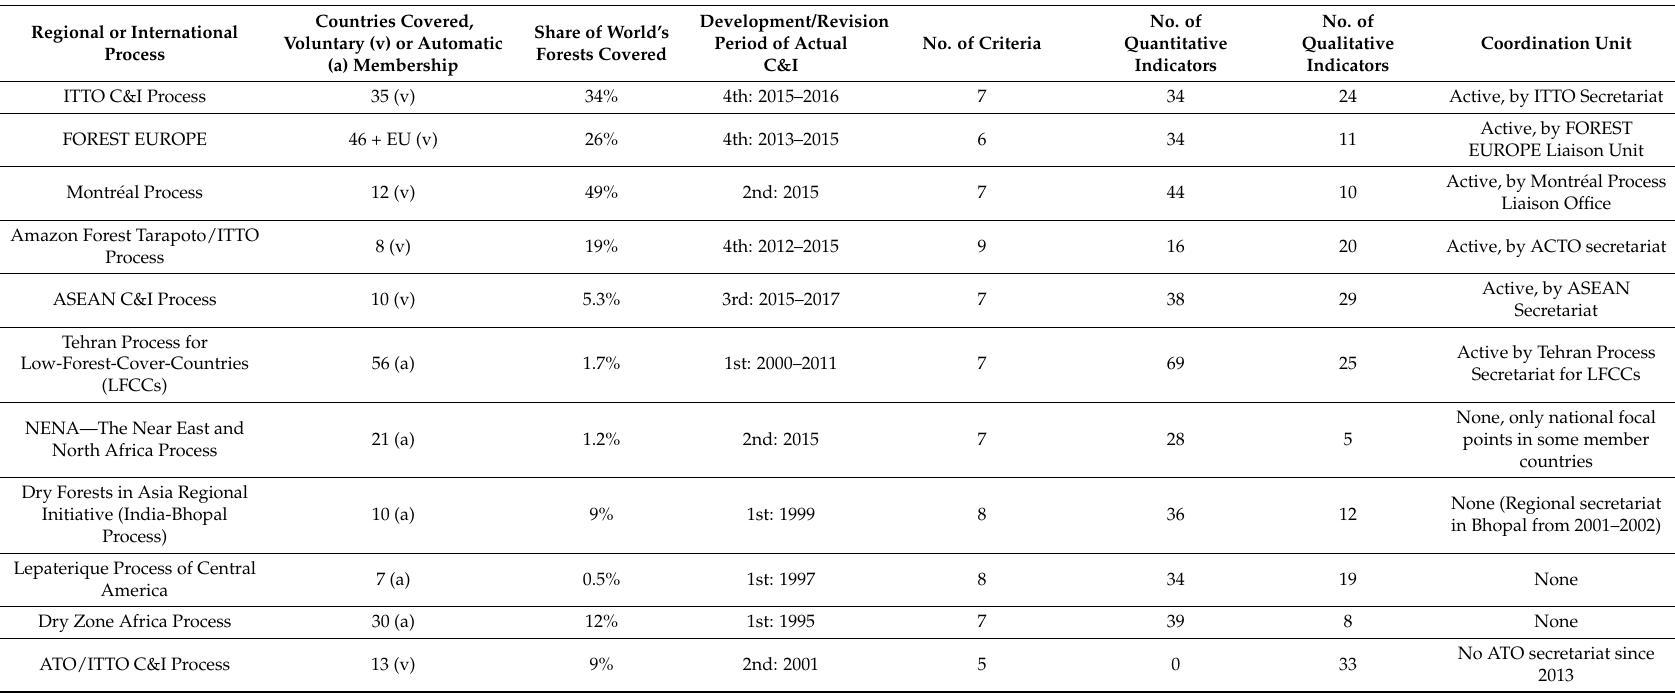
Table 1. Overview table on all regional and international processes and relevant parameters. Information based on expert input from the process secretariats and on literature for Lepaterique, Dry Zone Africa and ATO/ITTO processes. The share of the forest areas cannot be added up due to multiple memberships of some countries (cf. Figure